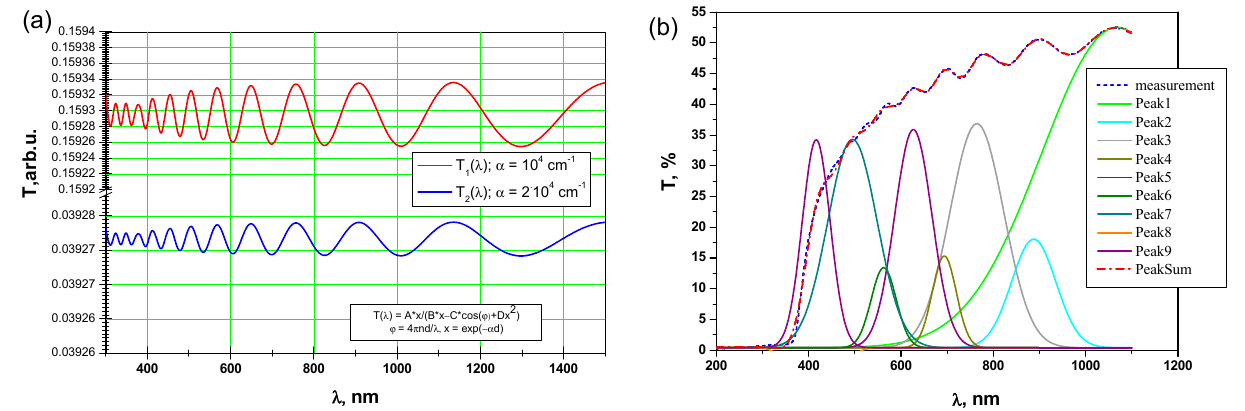
Figure 3. ( a ) Modeling of interference fringes using the Swanepoel method. ( b ) Adjusting the interference fringes of optical transmission with Gauss.